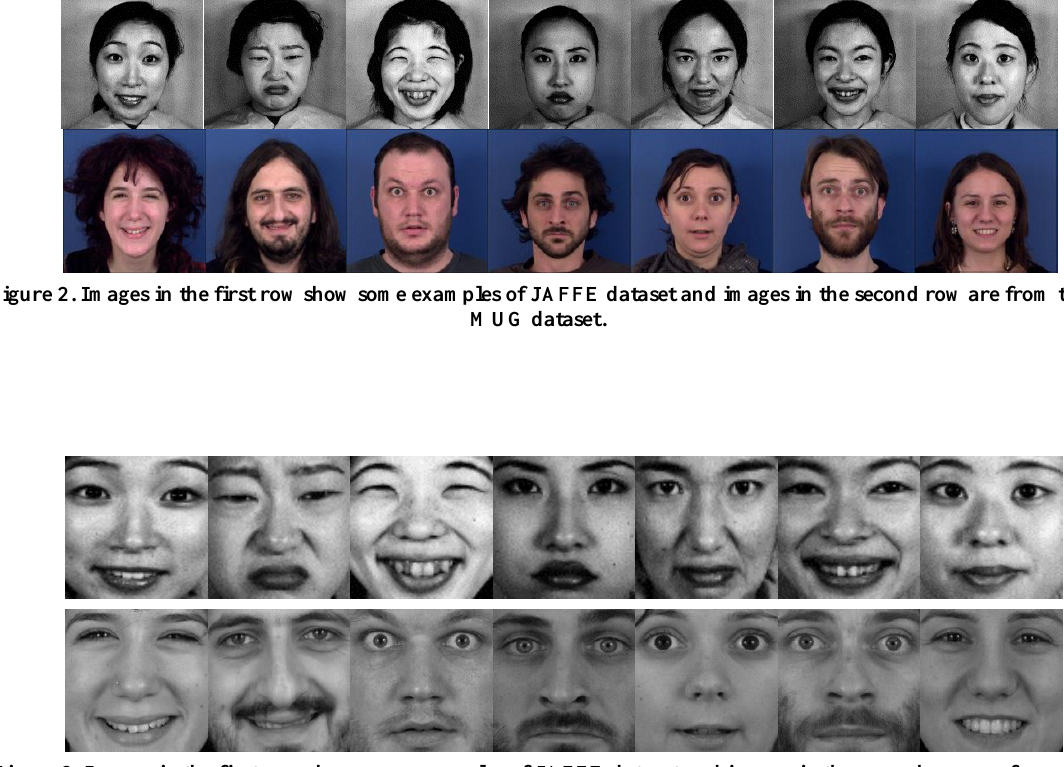
Figure 3. Images in the first row show some examples of JAFFE dataset and images in the second row are from the MUG dataset after